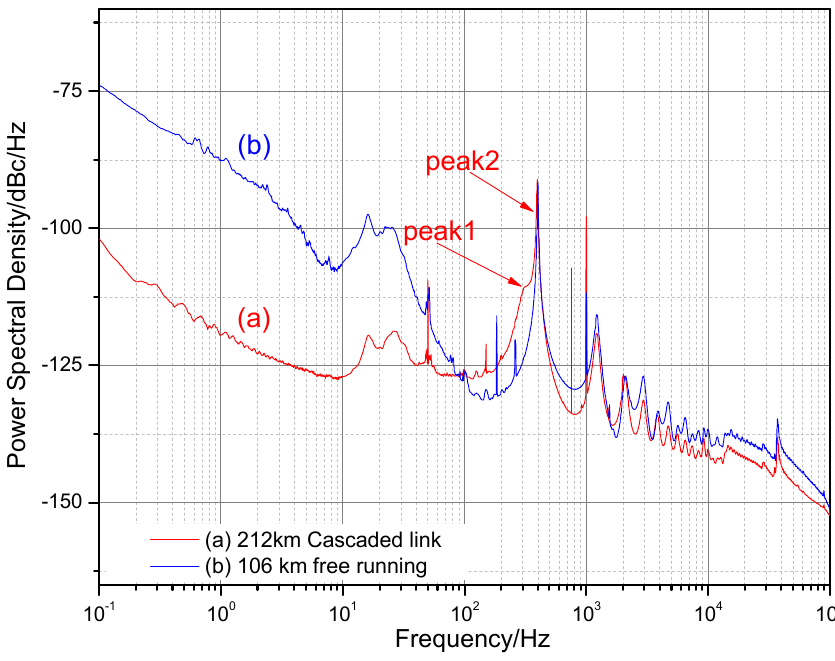
Figure 6. Residual phase noise of the cascaded system.